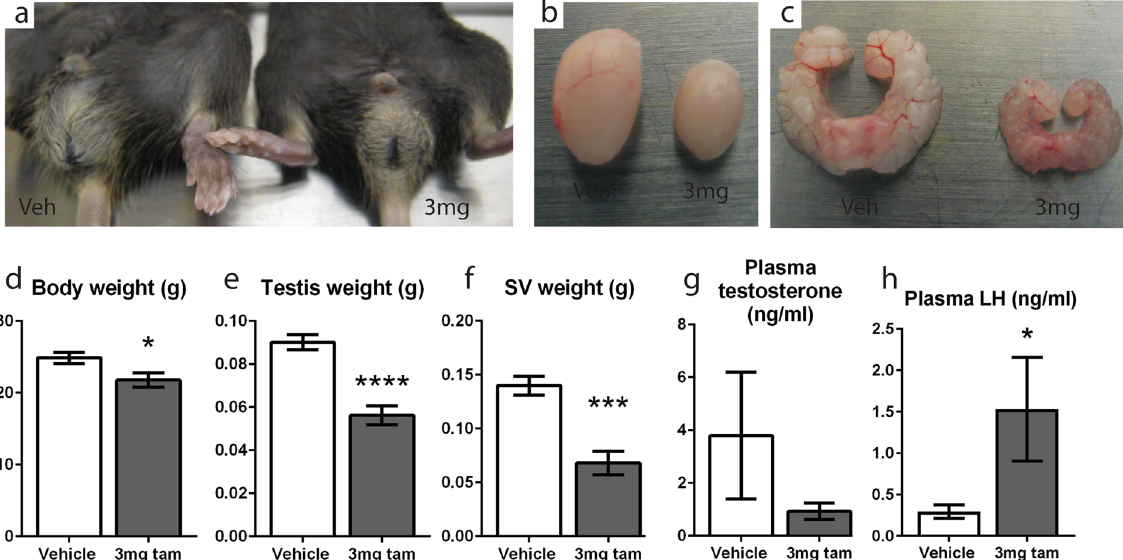
Figure 2. A single dose of 3 mg tamoxifen has long term endocrine effects in male mice. ( a ) INYF mice injected with 3 mg tamoxifen at d21 are cryptorchid at 5 weeks whereas the testes of non-treated INYF controls are not. ( b ) Testes of the d21 INYF tamoxifen-treated mice are visibly smaller than their non-treated littermate controls when examined at 7 weeks. ( c ) Seminal vesicles of the d21 INYF tamoxifen-treated mice are visibly smaller than their non-treated littermate controls when examined at 7 weeks. ( d ) C57bl/6 mice treated with a single systemic 3 mg dose of tamoxifen at d16 have significant reductions in body weight, ( e ) testis weight and ( f ) SV weight when examined at 7 weeks. ( g ) C57bl/6 mice injected with tamoxifen at d16 have no difference in plasma testosterone at 7 weeks compared to the controls. ( h ) Plasma LH is significantly increased in tamoxifen-treated mice. Graph values are group means where n ≥ 7, error bars are